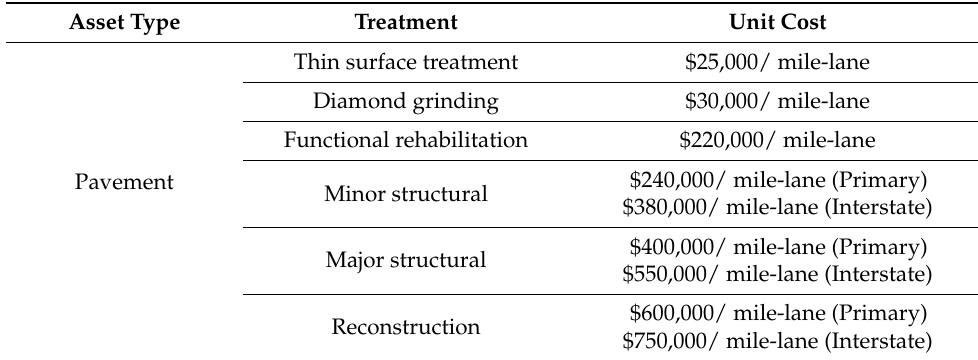
Table 5. Cost of treatment